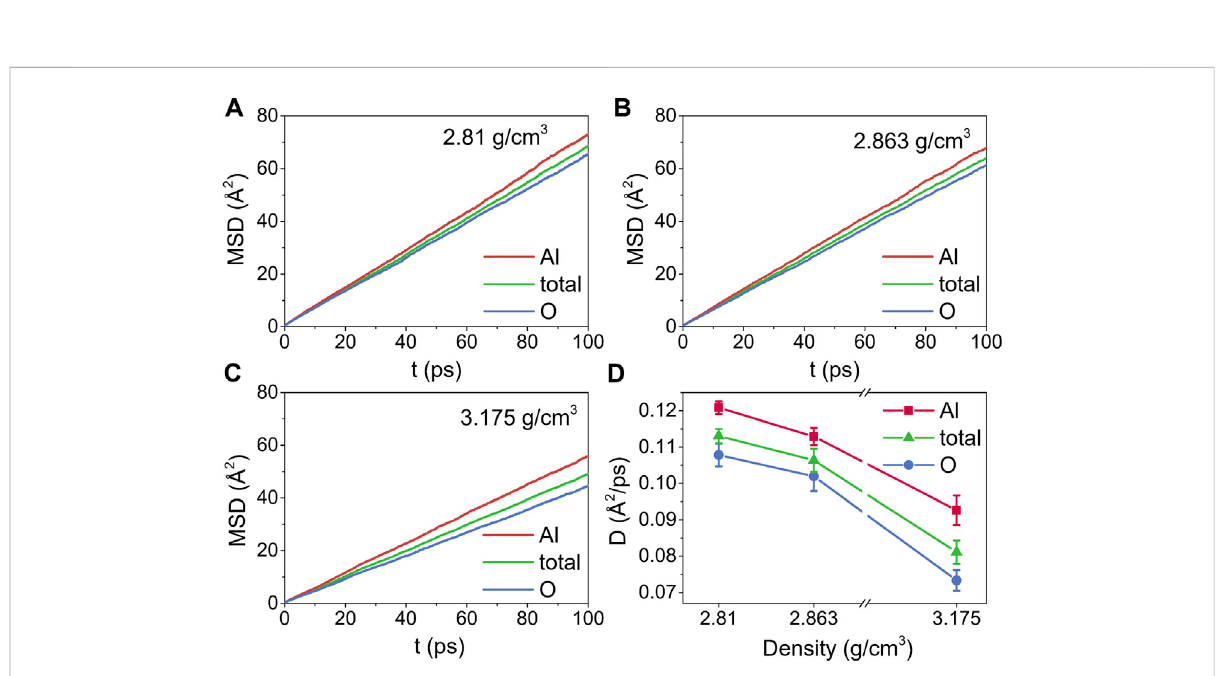
FIGURE 9 The time dependence of mean-squared displacements (MSDs) for liquid alumina at 2500 K, (A) ρ = 2.81 g/cm 3 , (B) ρ = 2.863 g/cm 3 and (C) ρ = 3.175 g/cm 3 , (D) self-diffusion coef fi cients (D) for liquid alumina at 2500 K and three densities.